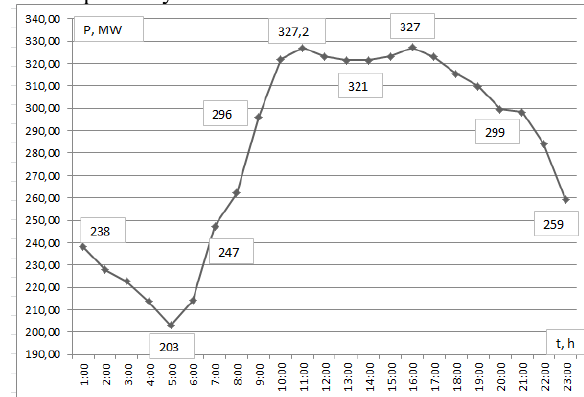
Fig.2 demonstrates a summer daily peak load curve for the power system.